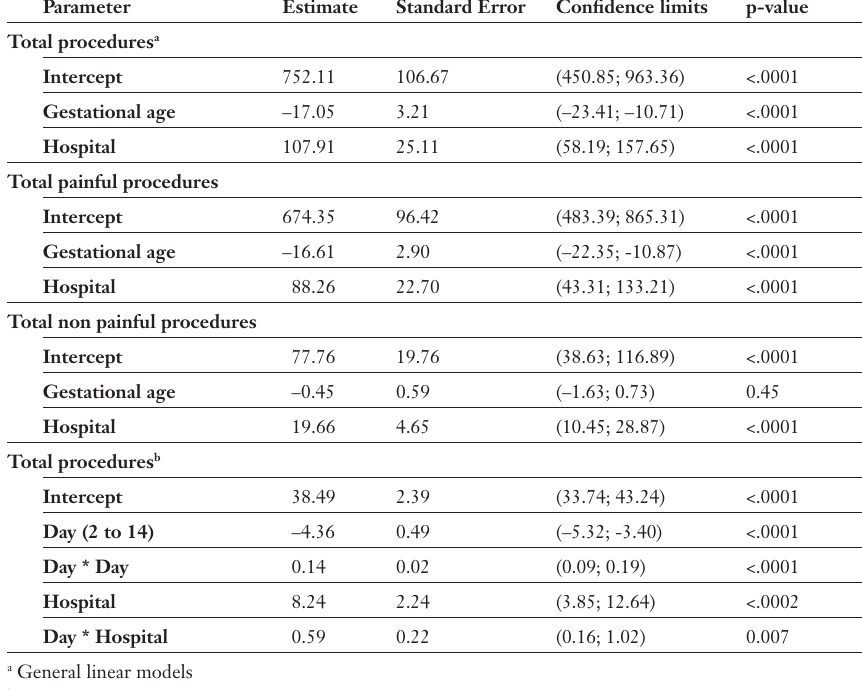
Number of proce- dures in study sam- ple during the first 14 days.